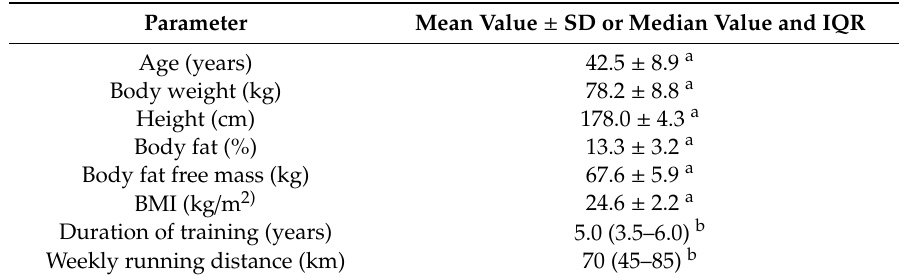
Table 1. Anthropometric and training characteristics at baseline and training history of subjects.